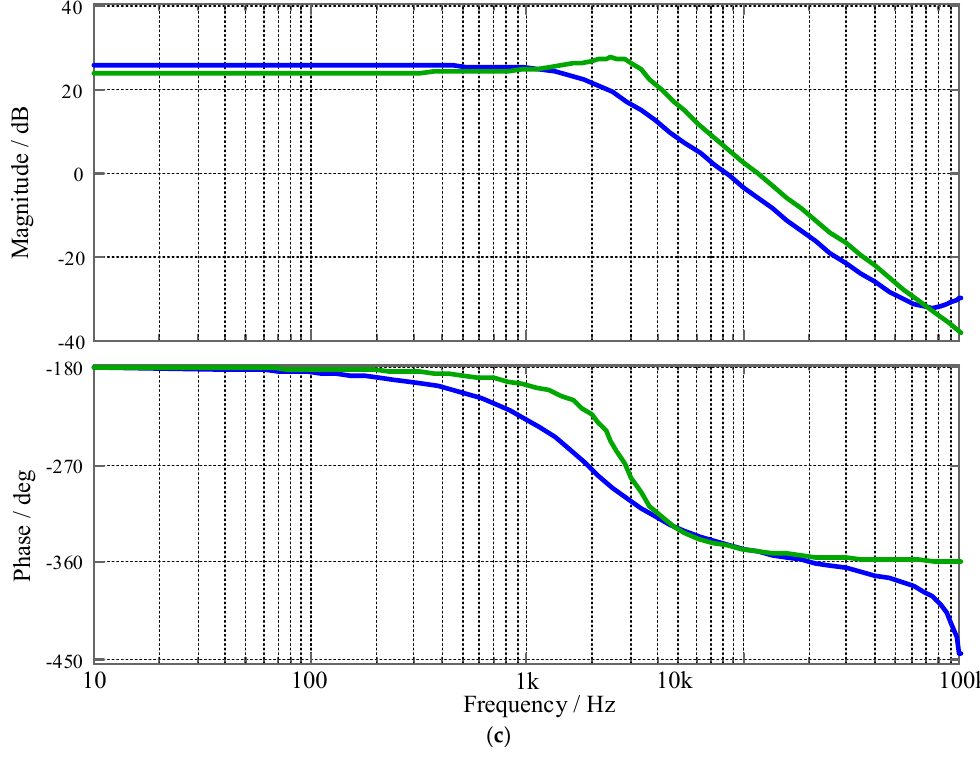
Figure 4. The bode plot of output voltage v o with respect to normalized switching frequency f s / f r using the small-signal model ( blue line ) and simplified model ( green line ): ( a ) below resonant frequency ( f s = 0.8 f r ); ( b ) at resonant frequency ( f s = f r ); ( c ) above resonant frequency ( f s = 1.2 f r ).